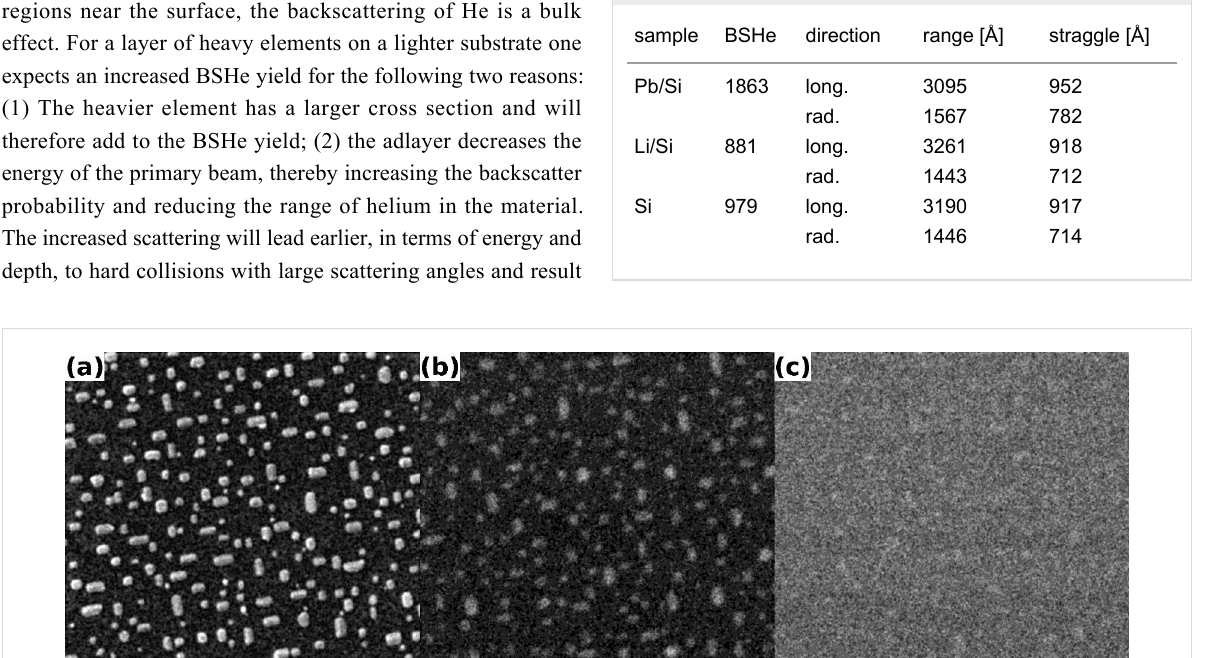
Table 1: Scattering process dependence on adlayer material as obtained by SRIM. For each adlayer/sample combination the number of backscattered helium atoms and the longitudinal and radial ion ranges (in Å) are given. 1 × 10 5 He ions with a PE of 35 keV under normal incidence were used in the